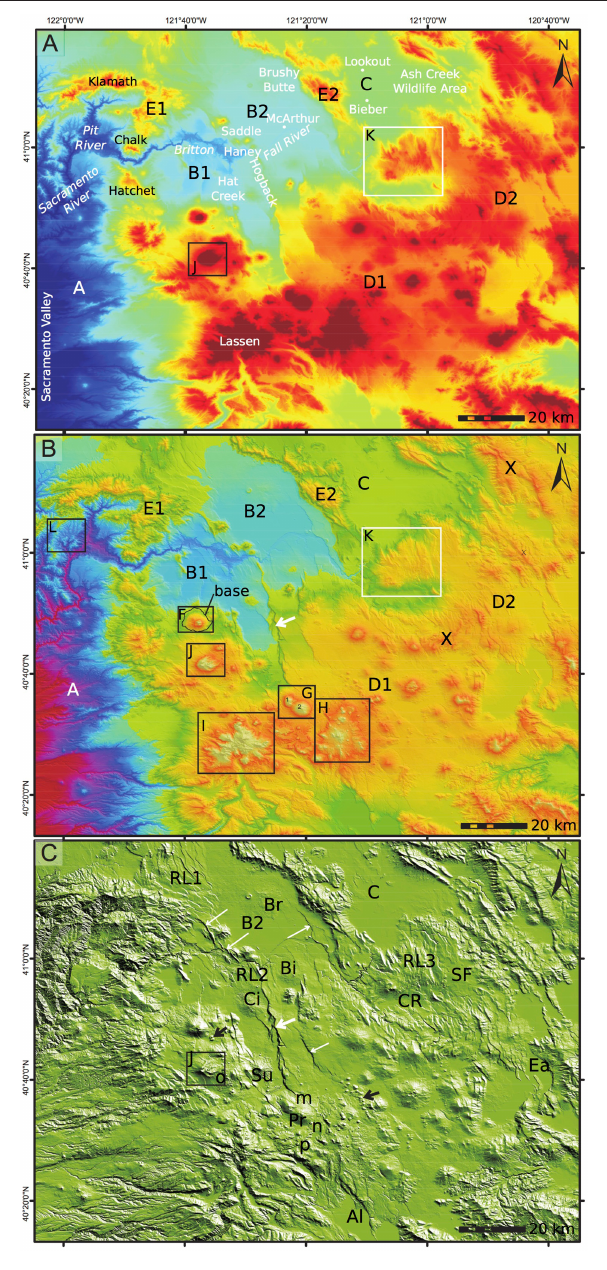
FIGURE 2 | Density-sliced DEM and Shaded Relief Maps of the Hat Creek Graben and its vicinity (Gesch et al., 2002). (A) Highlights the different elevation regions high in warm colors and low in cold colors and (B) green as the boundary between the two main regions and red as the break in slope that marks the bases of volcanoes. Based on mean elevation and continuity of elevation vs. adjacent areas, the low elevation areas are subdivided into A: Sacramento Valley and Sacramento River including its main tributary on the north, the Pit River; B1: Hat Creek Valley and Lake Britton, B2: McArthur and Fall River, and C: Lookout, Bieber and Ash Creek Wildlife Area. High elevation areas are subdivided based on texture and intensity of warm colors and geographic location. D1: Cascade Range; D2: Modoc Plateau; E1: Klamath Mountains; and E2: Taylor, Jimmerson and Widow Mountains. Red linear areas marked with x and K (inset) are ridges, features in insets F, G, and J